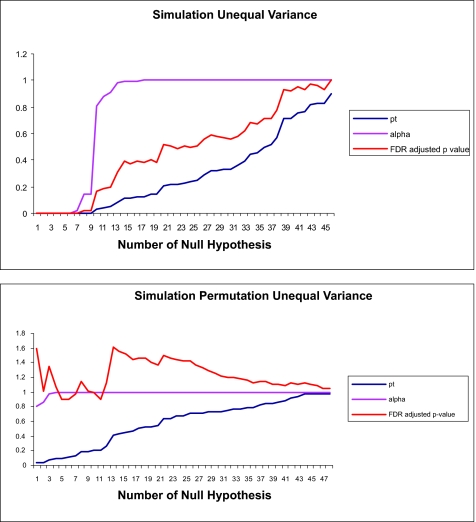
A. The plot of FDR adjusted p-value, experiment-wise type I error (FWER)(alpha) and comparison-wise type I error (CWER)(pt) in the simulated data set with ten genes and eight functional motifs and 50 motif-gene expression combinations. The x-axis is the number of hypotheses rejected and the y-axis is he probability level for the different statistical tests. B. The plot of FDR adjusted p-value, experimentwise type I error (FWER) (alpha) and com-parisonwise type I error (CWER)(pt) in the shuffled simulation data set with ten genes and eight functional motifs and 50 motif-gene expression combinations. The x-axis is the number of hypotheses rejected and the y-axis is he probability level for the different statistical tests.